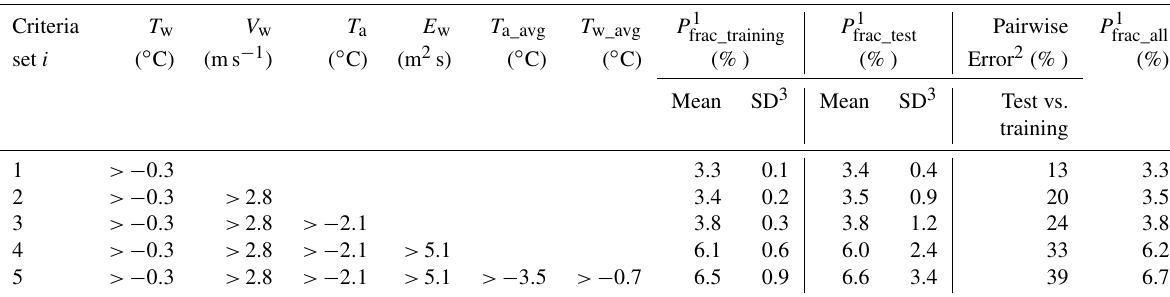
Figure 6. The fracture probability map for a descendant of the Petermann ice island from the 2010 calving event (a) , compared against the projected fracture probabilities for the same ice island in 2017–2018 (b) . The filled dots show the positions of the ice island at the time it was born and the time it fractured. Table 5. Model validation for some of the criteria sets in the model (e.g., criteria set i = 5 shows one of the 64 state combinations of the six variables; criteria set i = 4 represents one of the 16 state combinations of the four variables). The variables included water temperature ( T w ), wind speed ( V w ), air temperature ( T a ), wave energy index ( E w ), lifetime mean air temperature ( T a_avg ), and lifetime mean water temperature ( T w_avg ). Model error is derived through statistical comparison of fracture probability estimations from training sets and test sets, obtained using the five-fold cross-validation